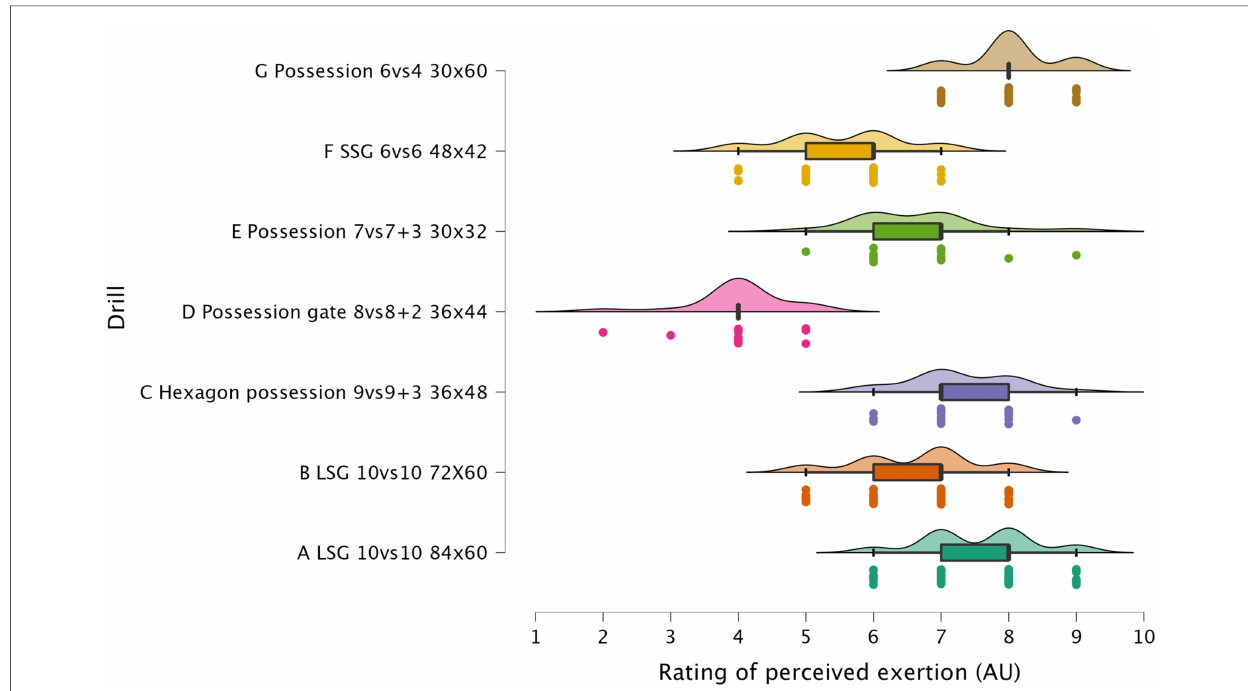
FIGURE 6 Comparison of RPE between drills. The data distributions show, mean, standard deviation, 95% con fi dence intervals, and individual data